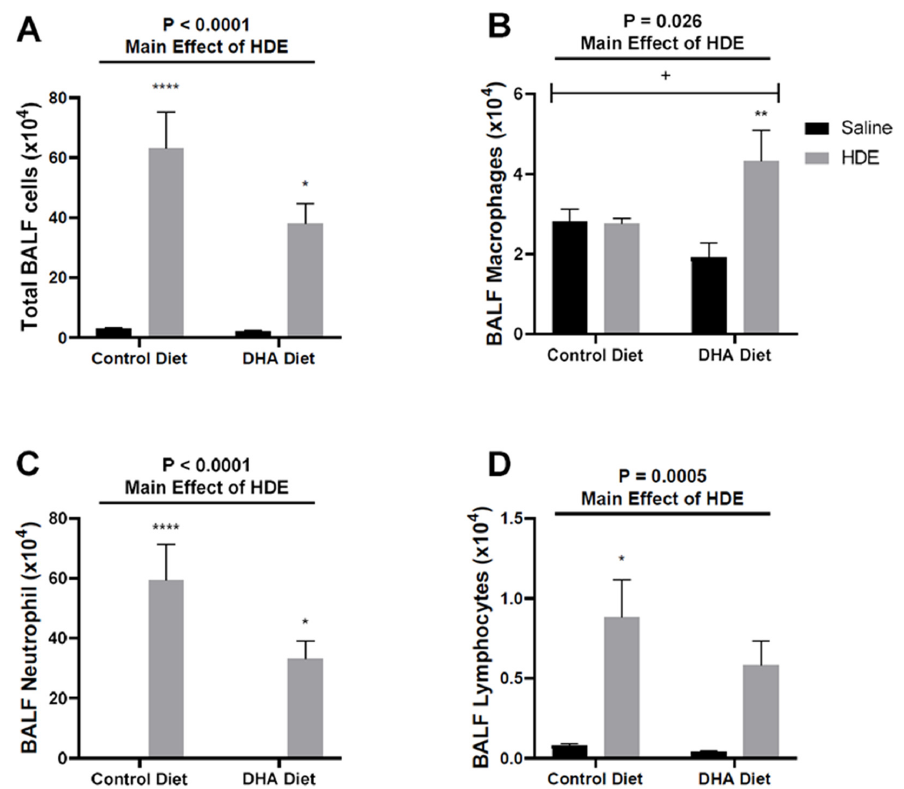
Figure 2. E ff ects of a high-DHA diet on total and immune cell lung influx after HDE instillation. Control- or DHA-diet-fed mice were challenged with a single intranasal HDE exposure. Five hours following exposure, bronchoalveolar lavage fluid (BALF) was collected and assessed for cellular influx including total BALF cells ( A ), BALF macrophages ( B ), BALF neutrophils ( C ), and BALF lymphocytes ( D ). The main e ff ects of HDE vs. saline are indicated by the top lines with corresponding p -values. The * symbol above the HDE bars represents the statistical significance of the di ff erence between the HDE- and saline-treated conditions within the same diet group (* p < 0.05; ** p < 0.01; **** p < 0.0001). Significant interactions between diet and exposure are depicted by the + symbol ( + p <